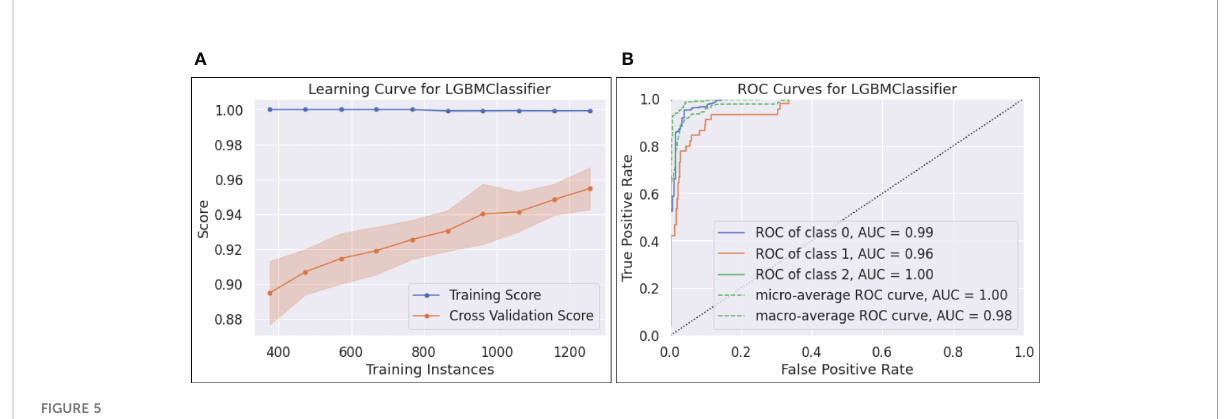
The highest scores for each metric are marked in bold. Figure 5-(b), the AUCs for the three classes were 0.99, 0.96, and 1.0, and the micro and macro-average AUCs were 1.0 and 0.98, respectively. The results show that the selected LGBM model was robust and performed well with different thresholds. However, we found that the AUC score of 0.96 for class 1 (i.e., cirrhosis) overstated its performance on this class, re fl ected by a relatively low F1 for cirrhosis (see 6-(b)). (cid:129) Figure 6-(a) reports the confusion matrix of LGBM on the test set. The results shown in the matrix are aligned with our observations on the decision boundary chart. Classes 0 (HBV) and 2 (HCC) were well-predicted, while class 1 (cirrhosis) samples were easily classi fi ed into class 0, indicating that the current feature setting is effective to separate HBV and HCC but not so effective to distinguish HBV and cirrhosis.